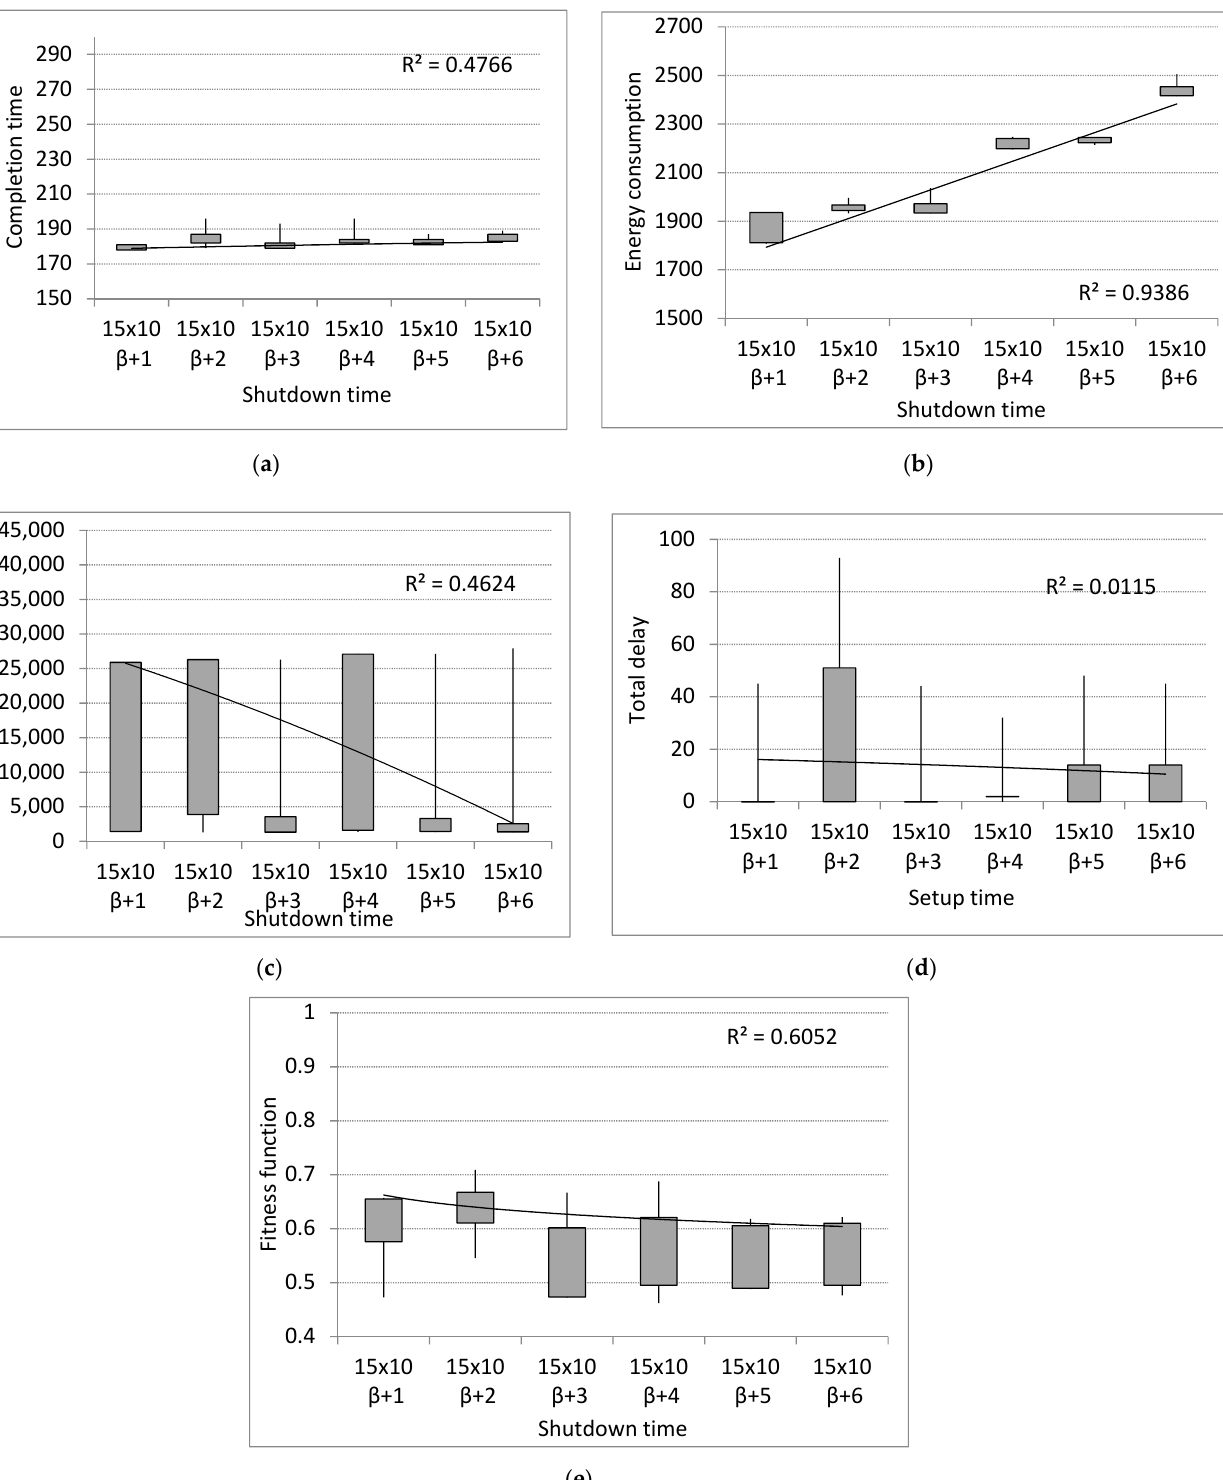
Figure 18. The influence of shutdown times β on ( a ) makespan, ( b ) cost of energy consumption, ( c ) cost of tardiness or premature execution, ( d ) total delay of tasks, ( e ) scalar fitness function for scheduling problem 15 × 10.